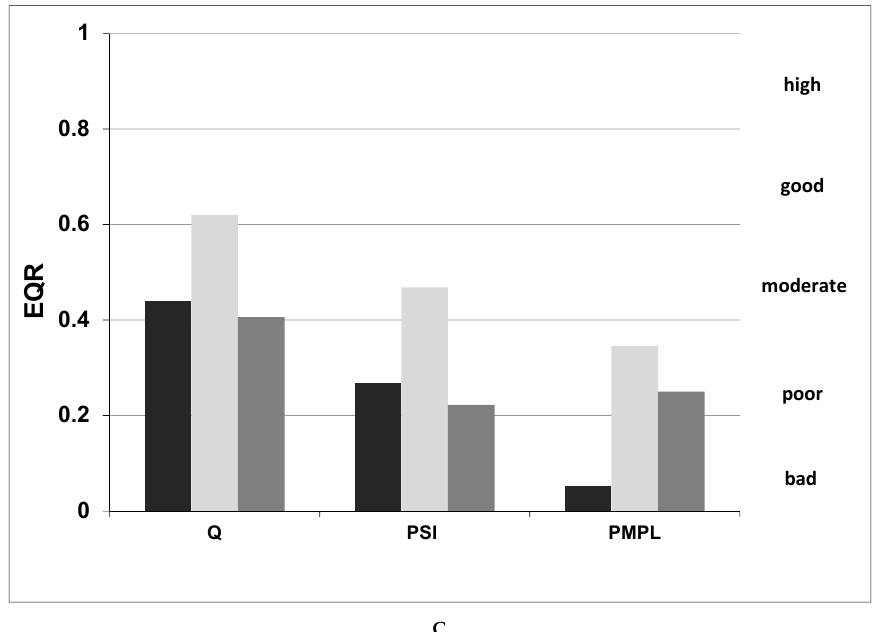
Figure 3. A . Ecological Quality (EQ) values and status class assessment according to PMPL metrics of lakes ecological status assessment (Polish method). Abbreviations: MBm–Metric of total biomass of phytoplankton, MChl a–Metric of chl- a concentration, MCY–Metric of biomass of cyanobacteria. B . Ecological Quality (EQ) values and status class assessment according to German metrics of lakes ecological status assessment. Abbreviation: PTSI–Metric Phytoplankton Seen Index. C . Ecological Quality Ratio (EQR) based on Q, PSI, and PMPL indices calculated for the studied lakes.